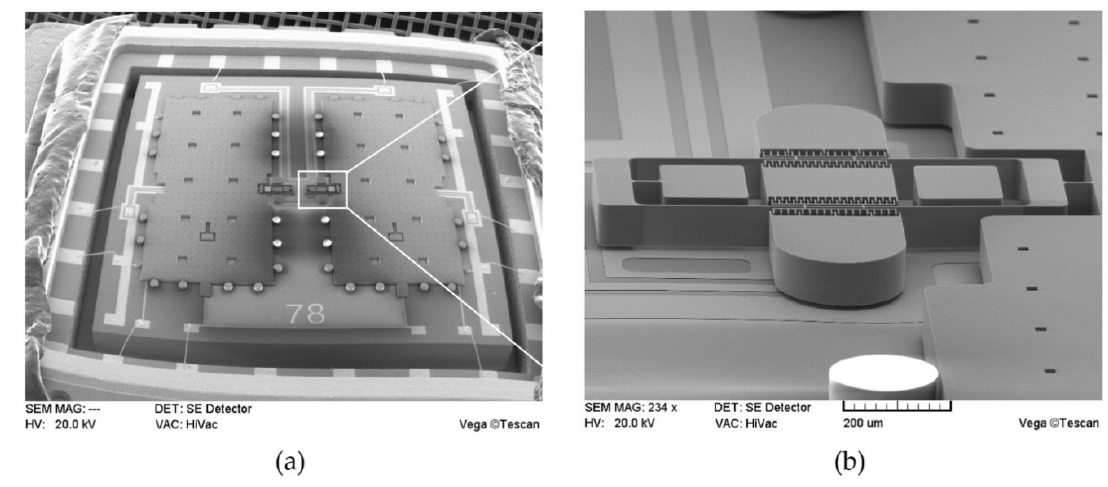
Figure 7. SEM (scanning electron microscopy) Image: ( a ) packaged DRA and ( b ) close up of the DETF resonator.